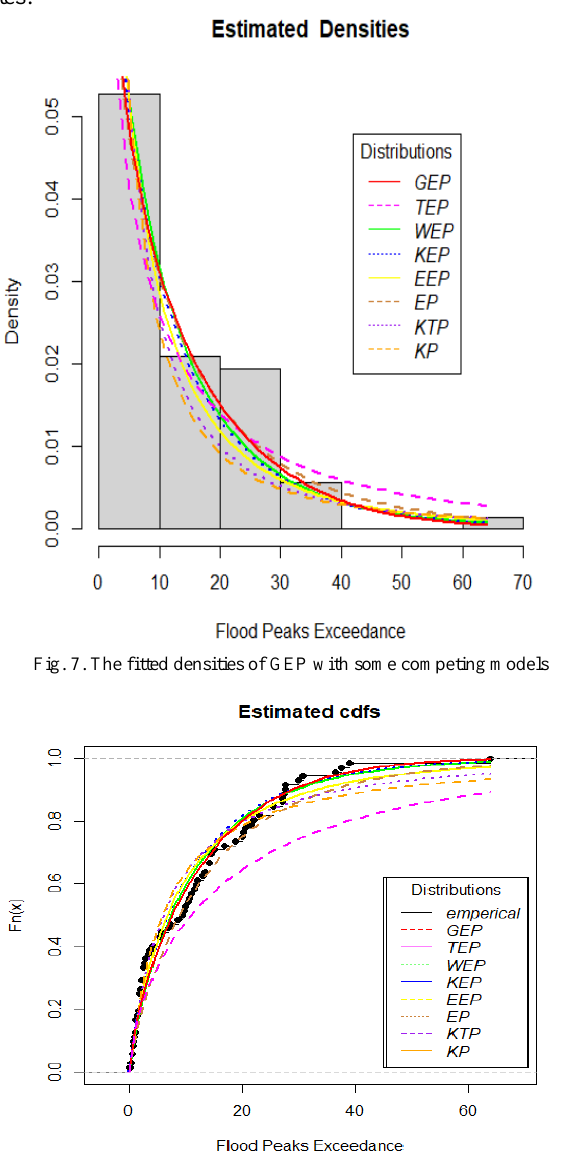
Fig. 8. The fitted densities of GEP with some competing